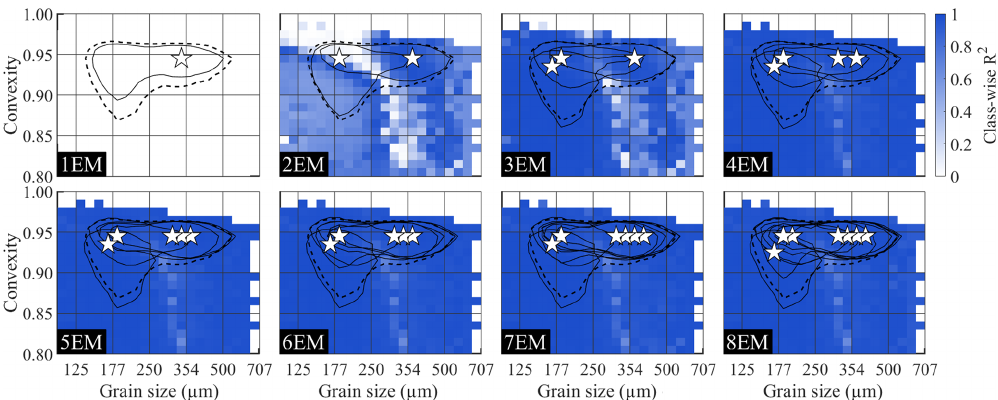
Figure 5. Class-wise R 2 distributions for endmember modelling results of the ConD2d 4EM_noise dataset. Solutions up to eight end- members are shown. Solid black lines denote endmember contours: lines drawn along those size–shape classes where the volume of the endmember SSD equals 0.5%. The median SSD of the dataset (average SSD) is represented by a dashed line at 0.2% volume. White stars denote the modes of the endmember size–shape distributions.